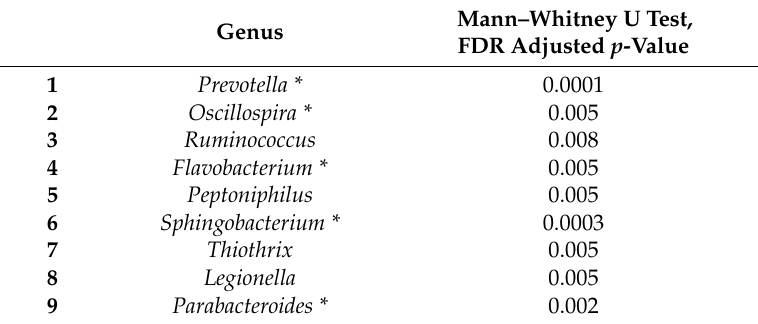
Table 1. The genera differentially abundant in the two microbiota